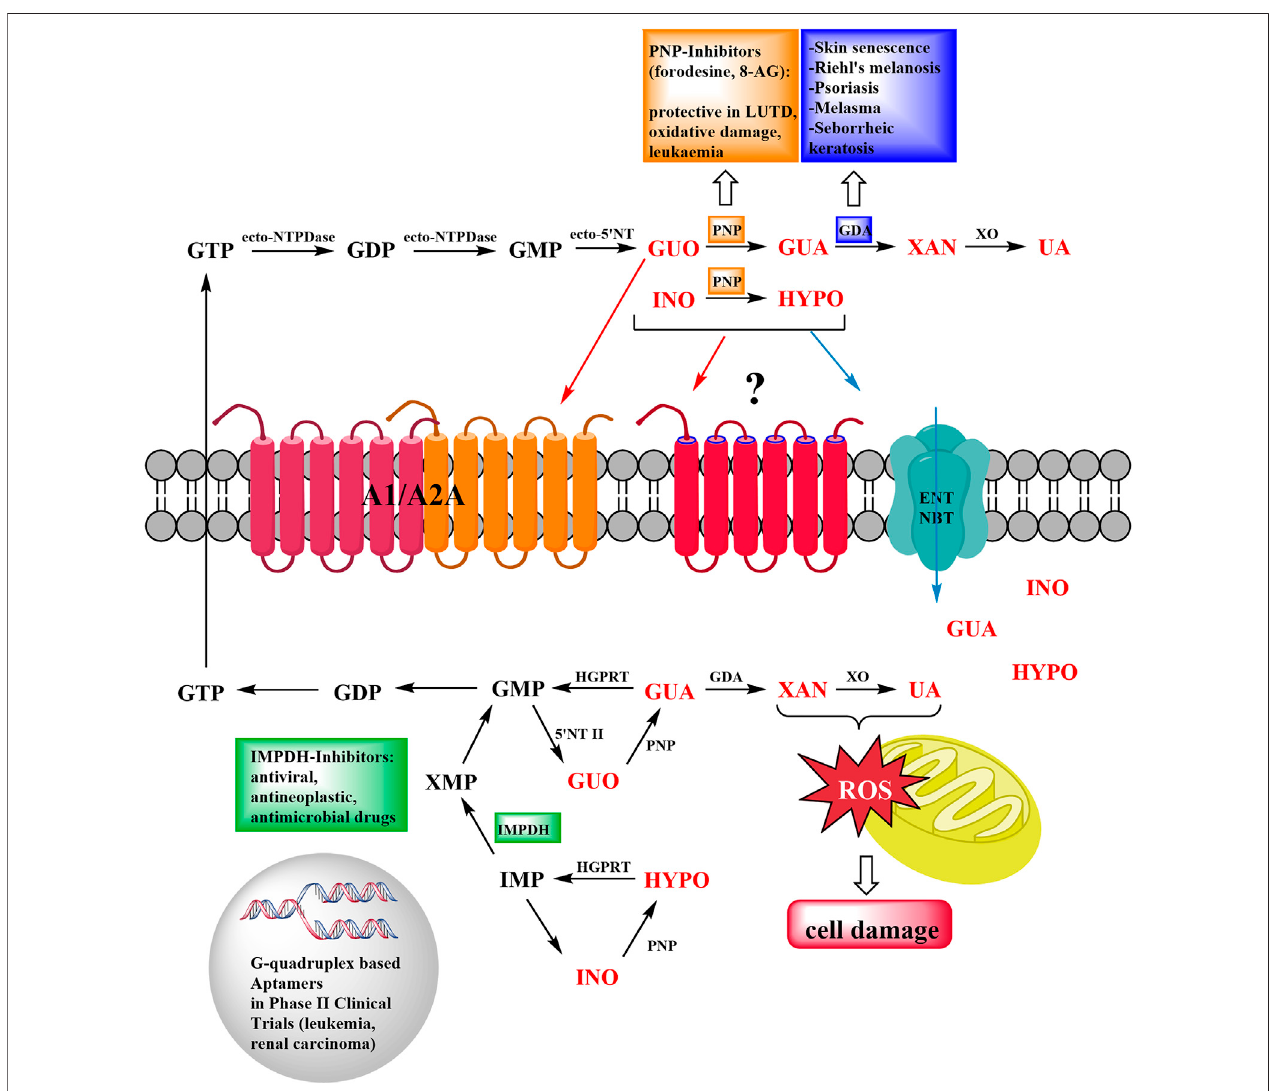
FIGURE 1 | Schematic representation of the roles of Guanine-Based Purines and their metabolizing enzymes in cancer and aging disorders. At extracellular level, guanine-based nucleosides are metabolized up to the formation of uric acid (UA), they can also interact with adenosine (A1/A2A)/unknown metabotropic receptors, or enter the cell via speci fi c equilibrative nucleoside transporters (ENT and NBT). At intracellular level, de novo and purine salvage pathways restore the purine nucleotide pool. Pharmacological manipulation of purine-converting enzymes demonstrated a therapeutic potential in LUTD, oxidative damage and leukemia (PNP), skin disorders (GDA), viral and microbial infections (IMPDH). Ecto-NTPDase: Ecto-nucleoside Triphosphate diphosphohydrolase; PNP: Purine Nucleoside phosphorylase; GDA: Guanine deaminase; XO: Xantine oxydase; HGPRT: Hypoxanthine-guanine phosphoribosyltransferase; 5 ′ -NT II: Cytosolic 5 ′ -nucleotidase II; IMPDH: Inosine Monophosphate